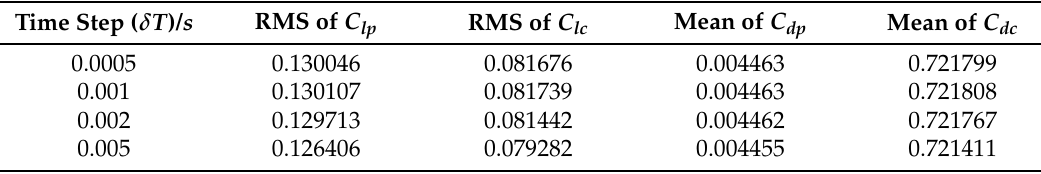
Figure 3. Verification of the lift coefficient with different time steps ( δ T is the time step; C lp and C lc is the lift coefficient on the plate and the cylinder, respectively). Table 2. RMS of lift and mean of drag coefficient at different time steps.